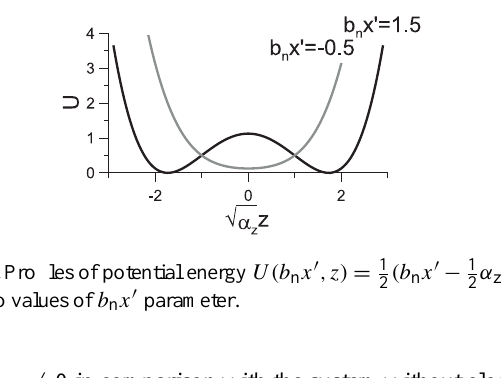
Fig. 2. Two particle trajectories in the system with w D = 0 (solid curve) and in the system with w D = 1 . 5 (dotted curve). The gray circles show initial positions of particles. Gray dotted line and grey arrows show moment when particles reach the boundary | x | = ‘ x .